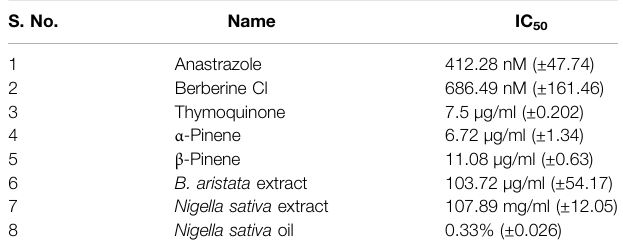
TABLE 4 | Inhibitory concentration (IC 50 ) values of standards and test compounds. S. No.